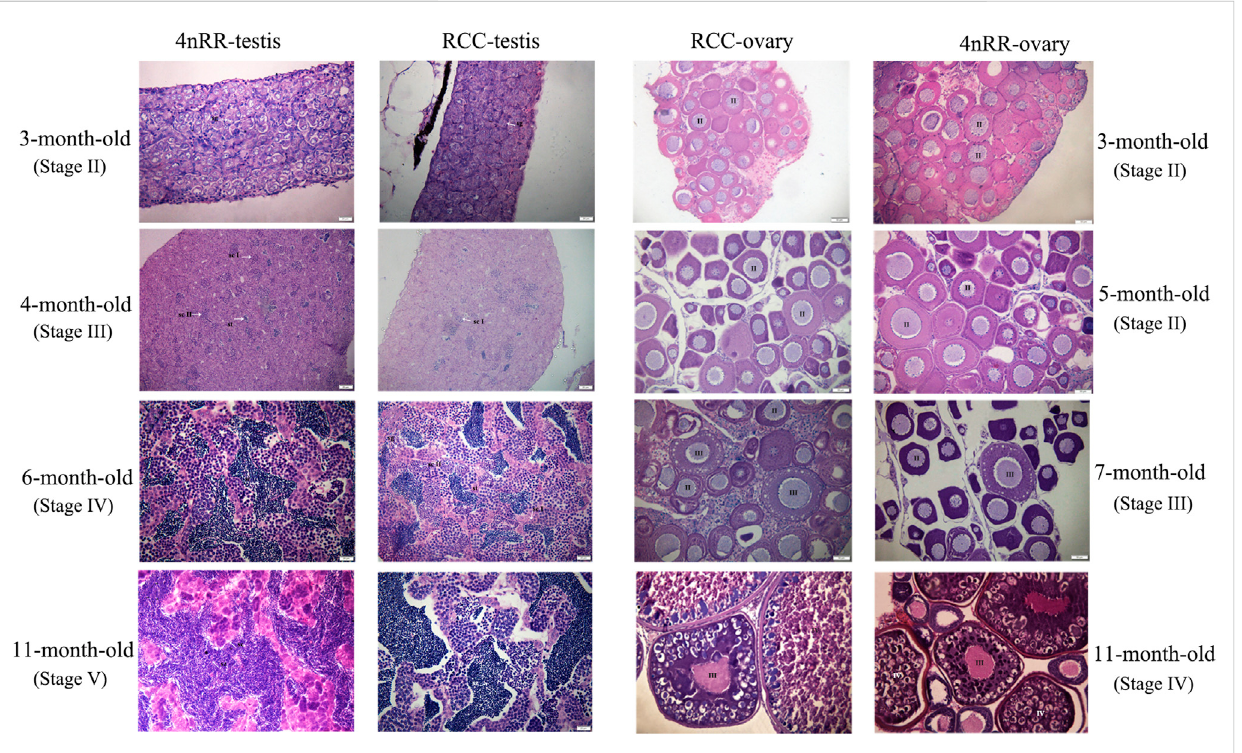
FIGURE 5 Gonadmicrostructureofdifferentagestagesoffemales(3,5,7,and11-month-old)andmales(3,4,6,and11-month-old)inbothRCCand4nRR.Sg, Spermatogonium;Sc,Sertolicell;St:Spermatid;Sz:Spermatozoa;ScI:Primaryspermatocytes; ScII:Secondspermatocytes;II,phase Ⅱ oocyte; Ⅲ ,phase Ⅲ oocytes; Ⅳ , phase Ⅴ oocytes.